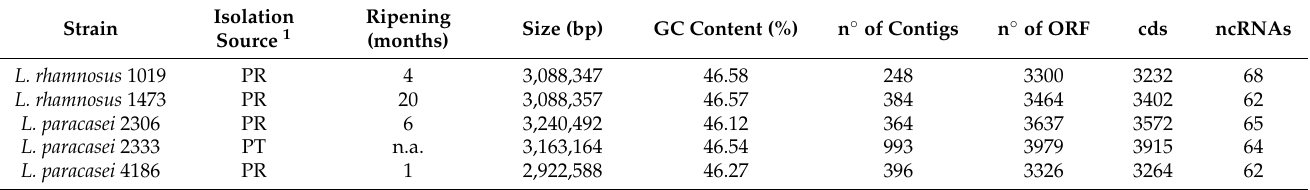
Table 1. Characteristics of the sequenced Lacticaseibacillus genomes. cds, protein coding sequences; ncRNAs, non-coding RNAs; ORF, open reading frame. Strain